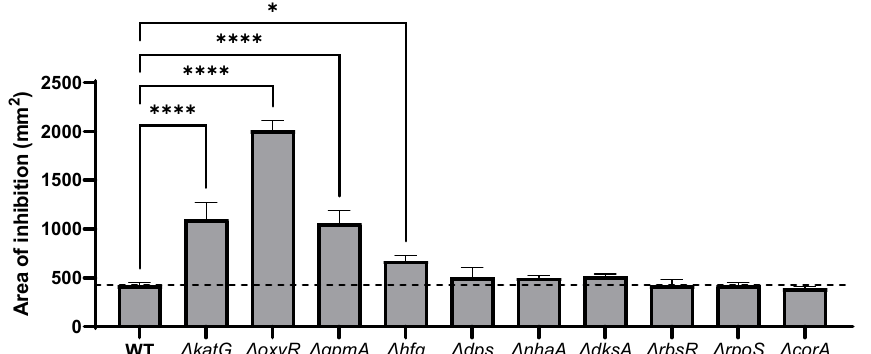
Figure 2. Sensitivity to H 2 O 2 of genes identified by TraDIS. The sensitivity to 10 µ L of 1 M H 2 O 2 of each single-gene deletion mutant identified by the TraDIS was assessed by disk diffusion assay. The coding regions of E. coli MG1655 (WT) were replaced by the kanamycin cassette of the corresponding mutant originated from the Keio collection using the phage P1 to ensure the absence of undesired mutation. Data were analyzed by one-way ANOVA with Tukey test for multiple comparison and *, **** correspond to p < 0.05 and 0.0001 respectively (mean +/ − SD, N = 3).